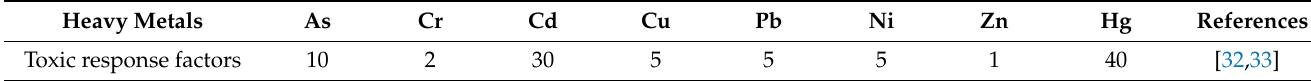
Table 1. Reference values of biological toxicity response factors of heavy